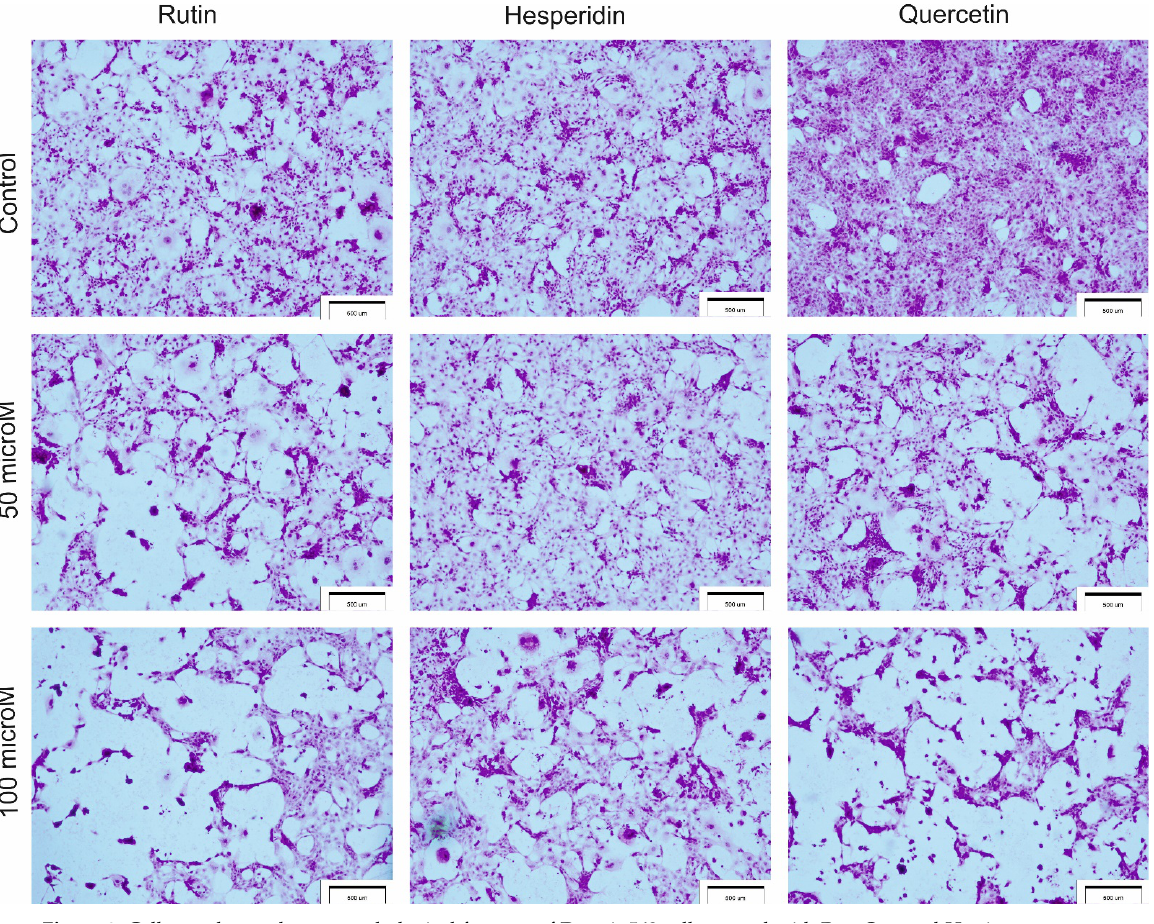
Figure 3. Cells number and cytomorphological features of Detroit 562 cells treated with Rut, Que and Hes in concentrations of 50 μM and 100 μM after 48 h of exposure (optical magnification = ×40). Detroit 562 cells grown as a control with DMSO solvent showed the characteristic monolayer of head and neck squamous cell carcinoma (HNSCC) cells with cellular atypia’s common characteristics: nuclear and cytoplasmic pleomorphism, increased nucleus vs. cytoplasm ratio, irregularly shaped cells, and hyperchromasia.